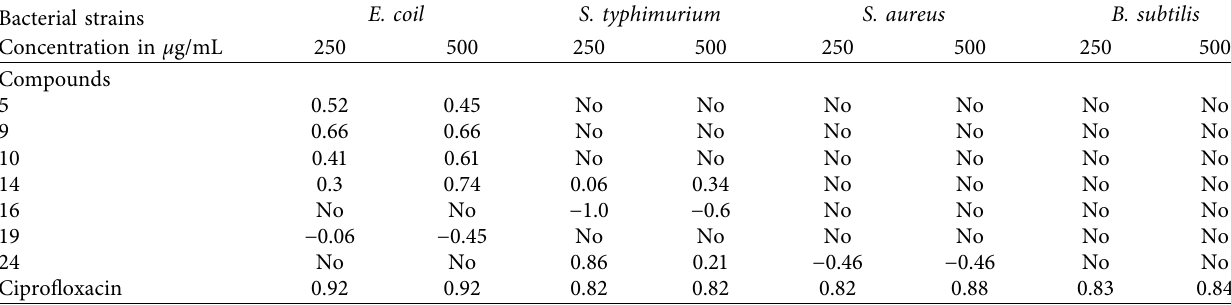
Table 7: The Z -factor of the antibacterial assay of the synthetic compounds and ciprofloxacin. Bacterial